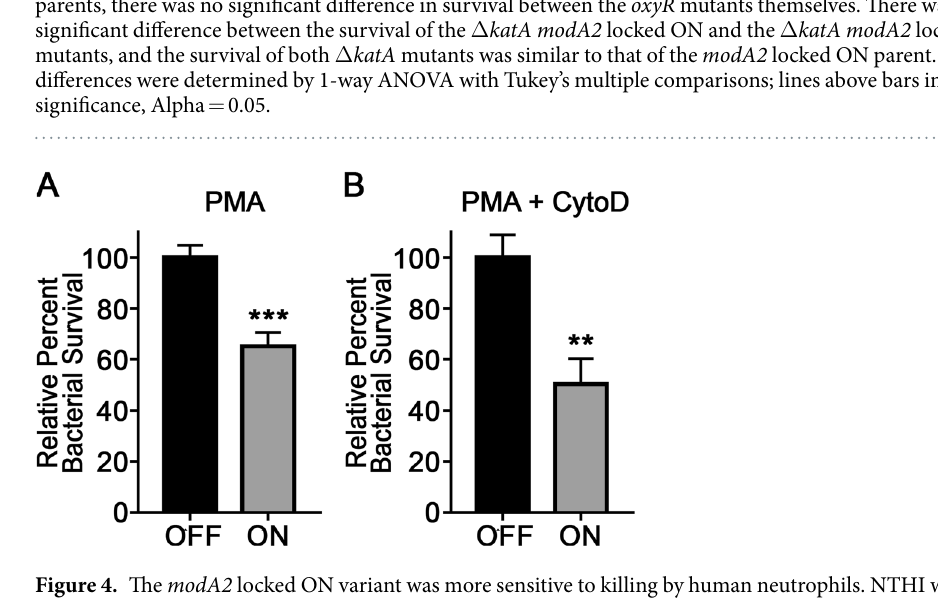
The modA2 locked ON and modA2 locked OFF subpopulations were exposed to neutrophils that had been highly activated by addition of phorbol 12-myristate 13-acetate (PMA). PMA is a known agonist of protein kinase C (PKC), which when stimulated activates NADPH-oxidase and subsequent production of ROS 22 . modA2 locked ON had significantly reduced survival in the presence of activated neutrophils compared to modA2 locked OFF (Fig. 4A, P < 0.0005, unpaired t-test). Neutrophils kill bacteria through phagocytosis as well as the release of ROS, antimicrobial peptides, proteases and NETs into the microenvironment 22–24 . To determine bacterial killing specif- ically due to ROS released as a product of the oxidative burst, neutrophils were pretreated with cytochalsin D, an inhibitor of actin polymerization, which prevented phagocytosis. When phagocytosis was blocked, modA2 locked ON was still significantly more sensitive to neutrophil-derived exogenous ROS compared to modA2 locked OFF (Fig. 4B, P < 0.005, unpaired t-test). Pretreatment of neutrophils with diphenyleneiodonium (DPI), an antagonist of NADPH-oxidase, prevented the release of ROS, but was also directly toxic to NTHI and therefore unable to be used in this assay 23, 25, 26 . These data suggested that the increased sensitivity of modA2 locked ON to oxidative stress lead to greater bacterial killing due to ROS generated by human neutrophils, as was seen with addition of exogenous H 2 O 2 in the in vitro assays above. Neutrophils release a multitude of antimicrobial agents as part of the innate immune response. To confirm which components released by neutrophils were responsible for the increased killing of modA2 locked ON,